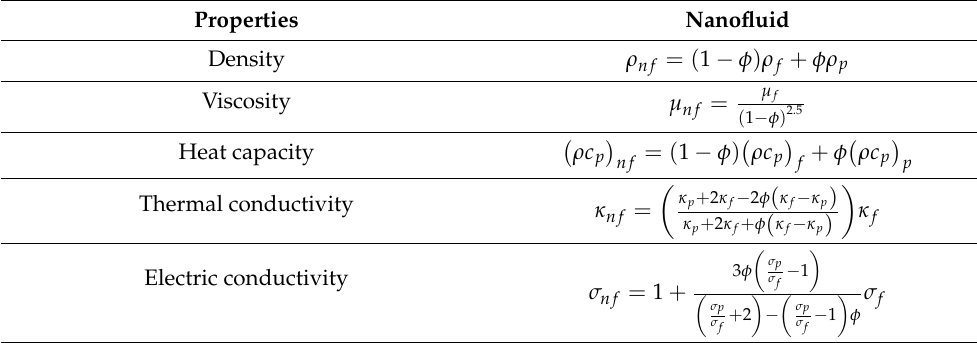
Table 1. Thermal properties of nanofluids.